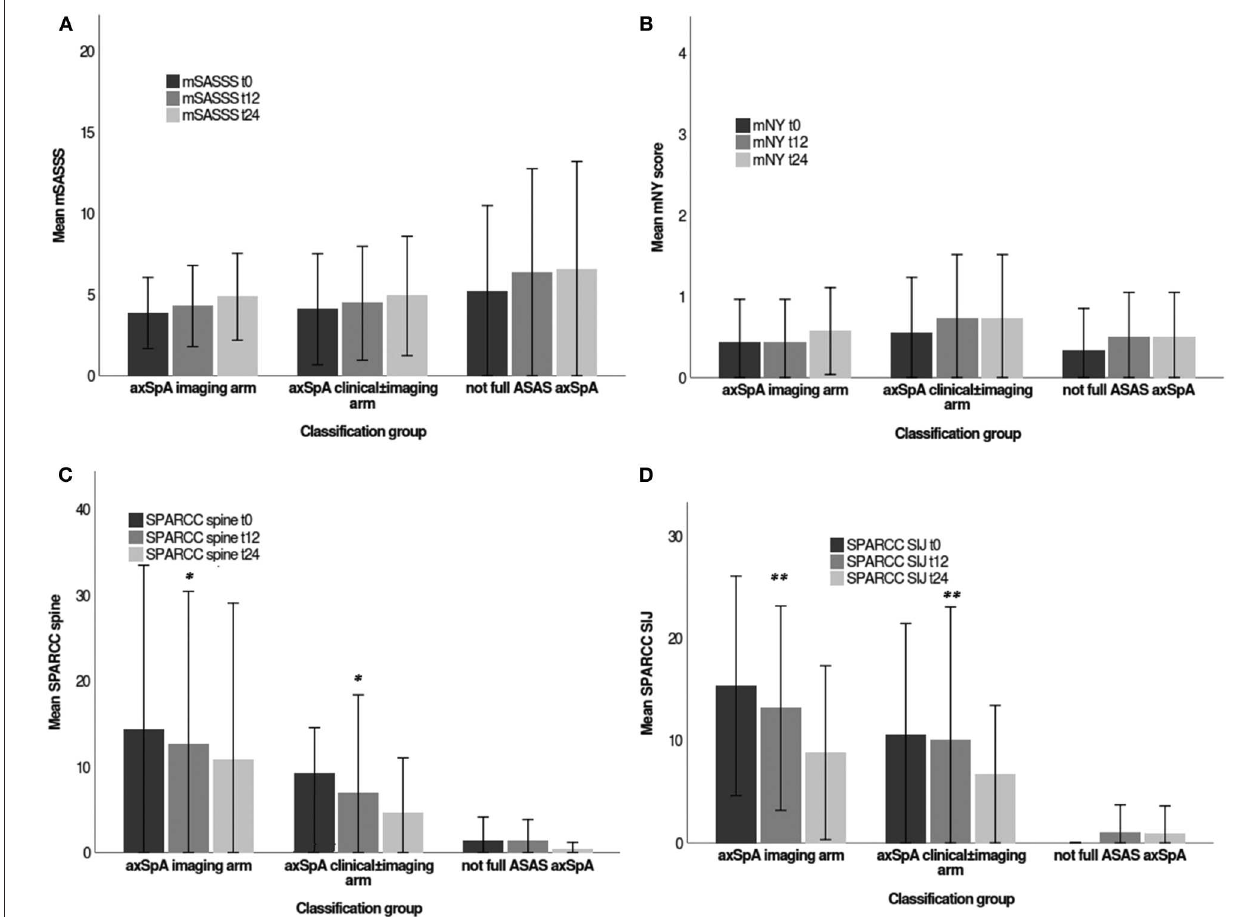
FIGURE 3 | (A–D) Imaging indices values (mSASSS, mNY score, SPARCC spine, SPARCC SIJ), expressed as mean (deviation standard) from T0 to T24 in the three cohorts ( axSpA imaging arm, axSpA clinical ± imaging arm, not full ASAS axSpA ). * p < 0.01 vs. T0, ** p < 0.001 vs. T0. Stoke Ankylosing Spondylitis Spinal Score (SASSS) system modified by Creemers (mSASSS); modified criteria of New York (mNY) score; Spondyloarthritis Research Consortium of Canada (SPARCC); Sacroiliac joint (SIJ). The written informed consent was obtained from the individual for the publication of these